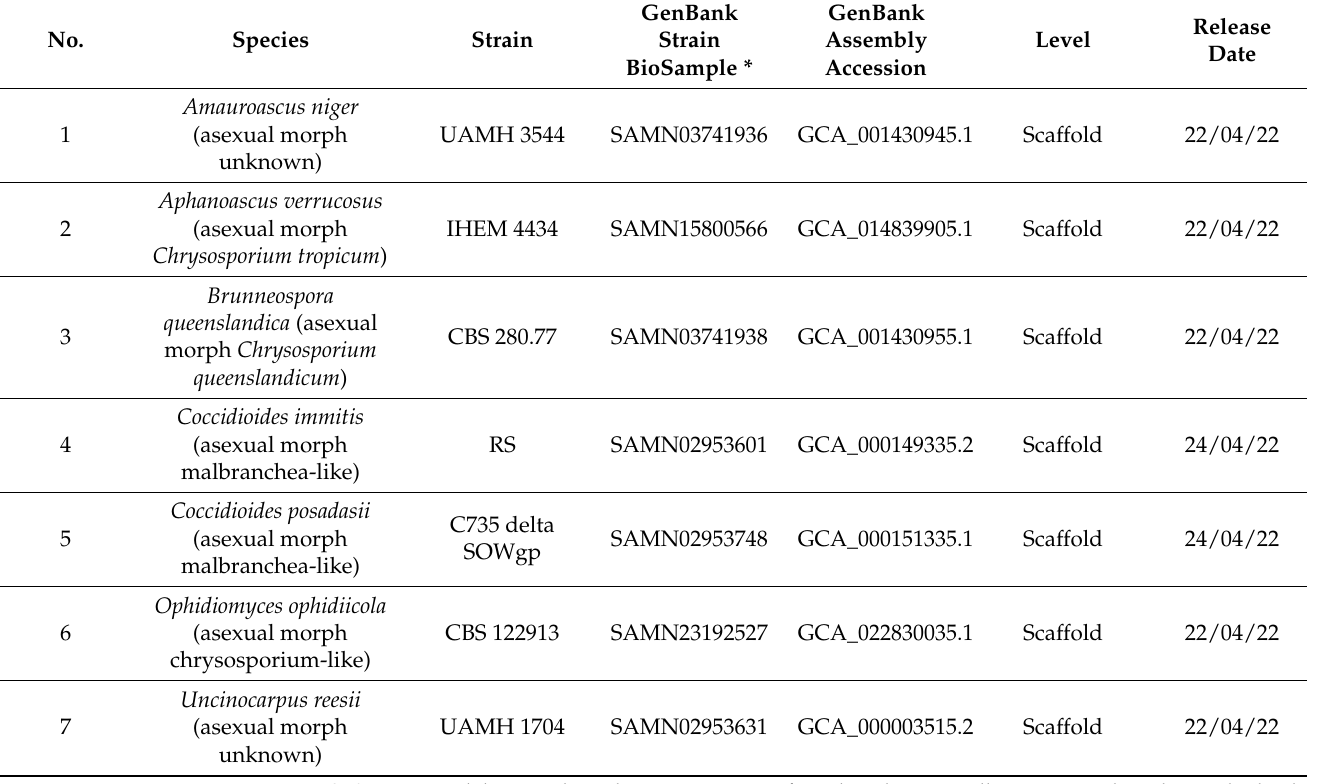
Table 1. Strains used in the average nucleotide identity (ANI)